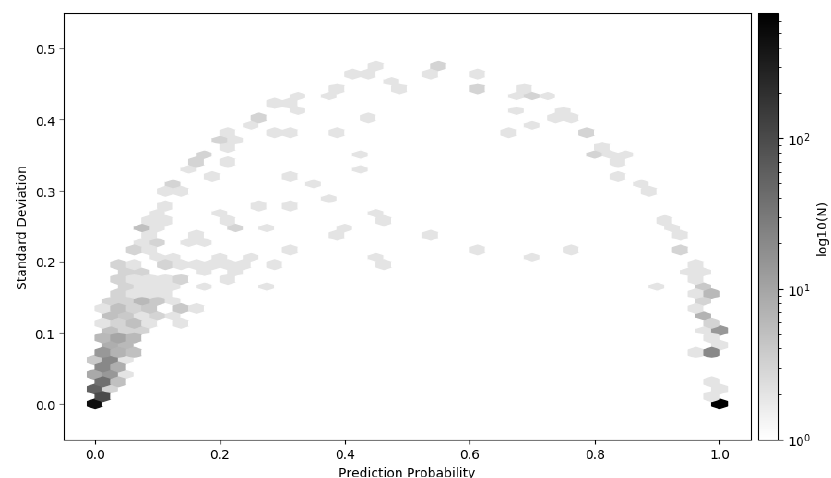
Figure 7. 2D histogram of the mean prediction and standard deviation of all the time series in the test data set. The majority of the time series are predicted near 0 or 1 with low standard deviation. The color pallet have log-scale to visualize the time series that are classified with high standard deviation and low distinction in the prediction